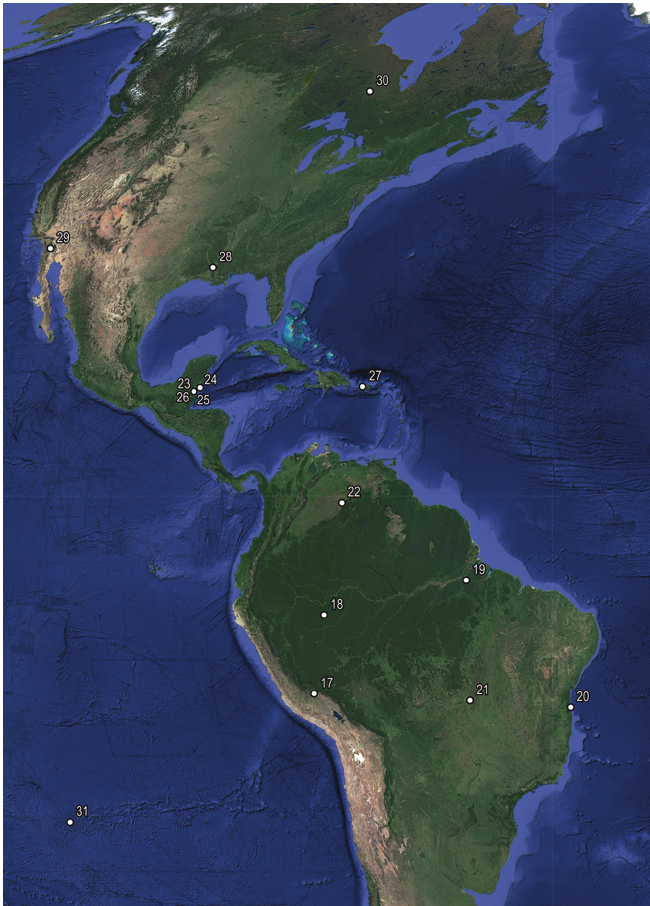
Figure 3 Map of the